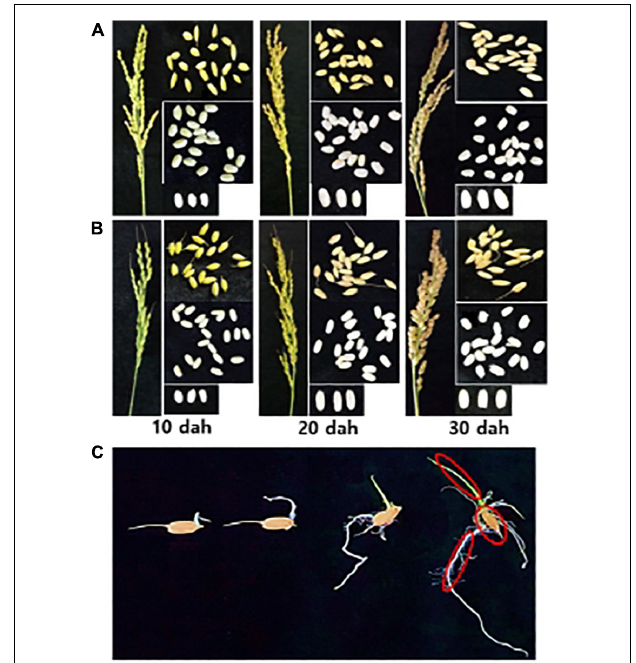
FIGURE 1 | Sampling of rice seed and seedling compartments. Rice panicle and seeds of (A) Sukwang and (B) Shindonngjin were collected at